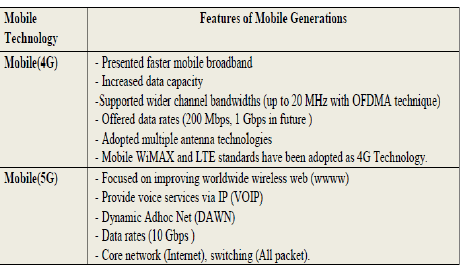
Table 1. Some Features of 4G and 5G